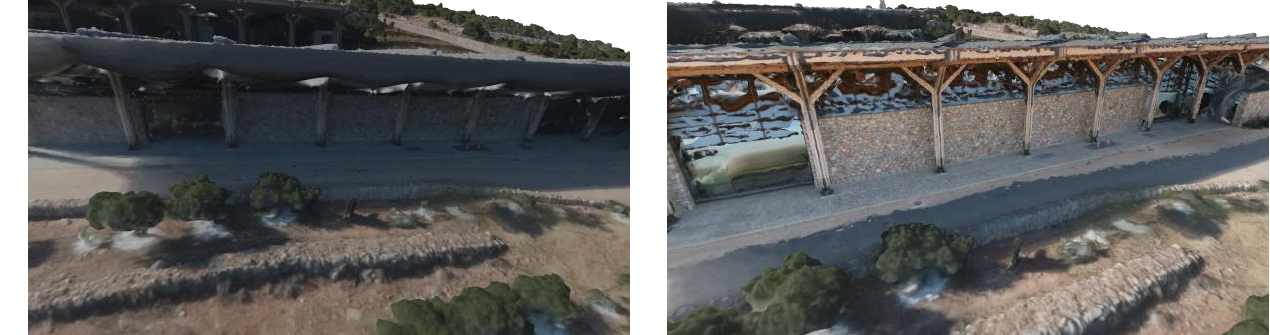
Figure 10. ( Left ): aerial reconstruction. ( Right ): a combination of aerial and terrestrial Figure 10. Left : aerial reconstruction. Right : a combination of aerial and terrestrial views.